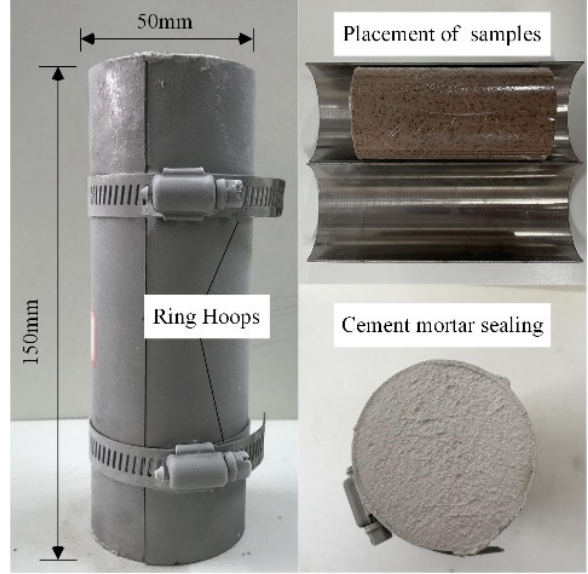
Figure 2. Homemade rock freezing and thawing jig.